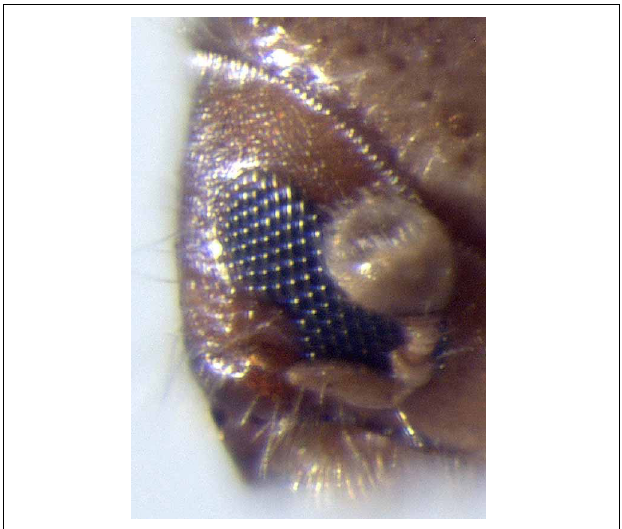
FIGURE 5 | Antenna of Premnophilus